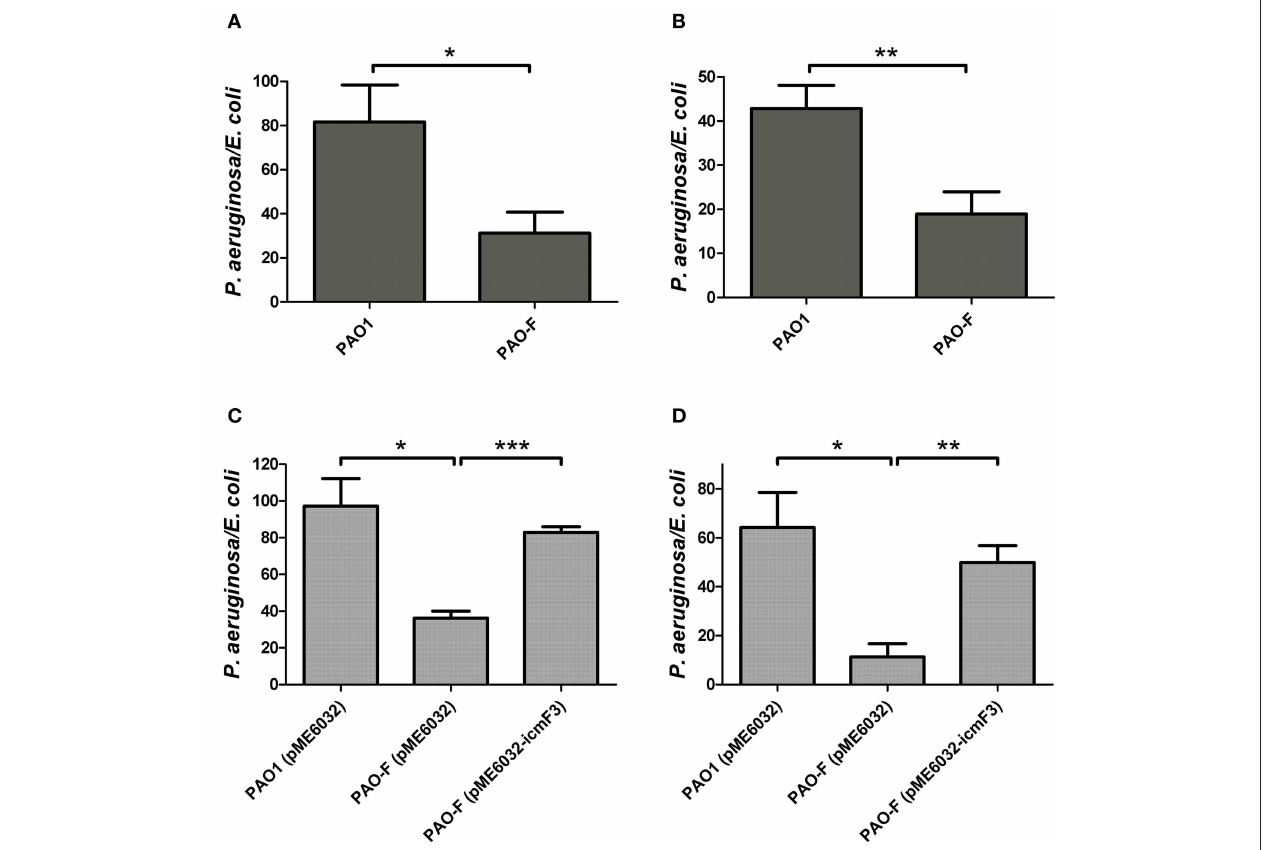
FIGURE 7 | Competitive growth outcome of the indicated P. aeruginosa strains (x axis) against E. coli DH5 α with pBBR1MCS-5 strain at 37 ◦ C for 36h. P. aeruginosa and E. coli strains were mixed in 1:2 ratio for (A,C) and in 10:1 ratio for (B,D) . If needed, 1mM IPTG was included in the medium for induction. The competitive index result is calculated as the final c.f.u. ratio ( P. aeruginosa / E. coli ) divided by the initial ratio. Error bars represent ± SD ( n = 3 ). * P < 0.05 , ** P < 0.01 , *** P < 0.001 .